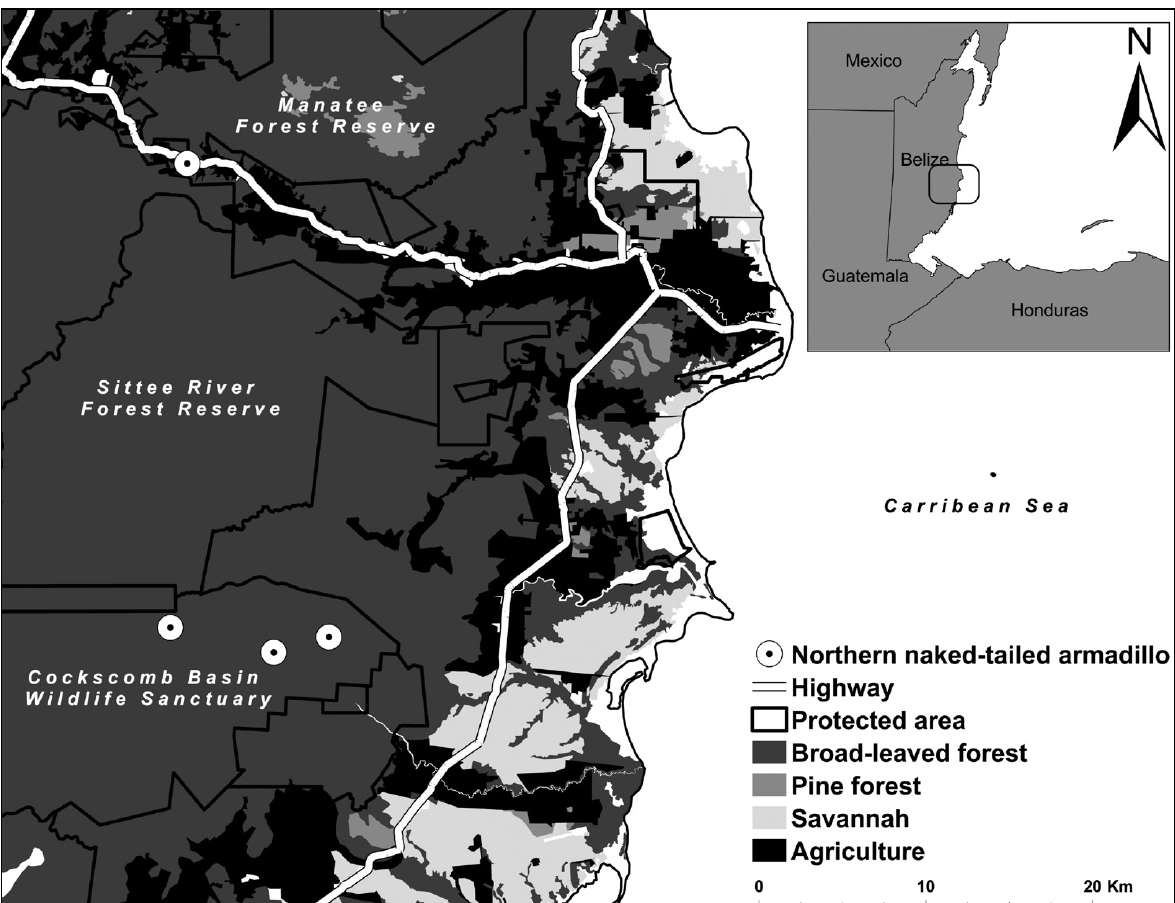
Figure 3. Locations of the new detections ( N = 4) of the Northern Naked-tailed Armadillo in